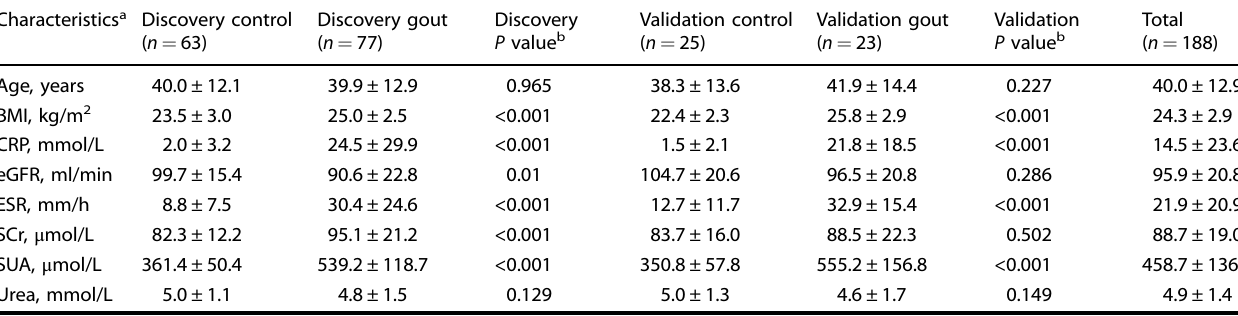
Table 1. The baseline characteristics of subjects in discovery and validation